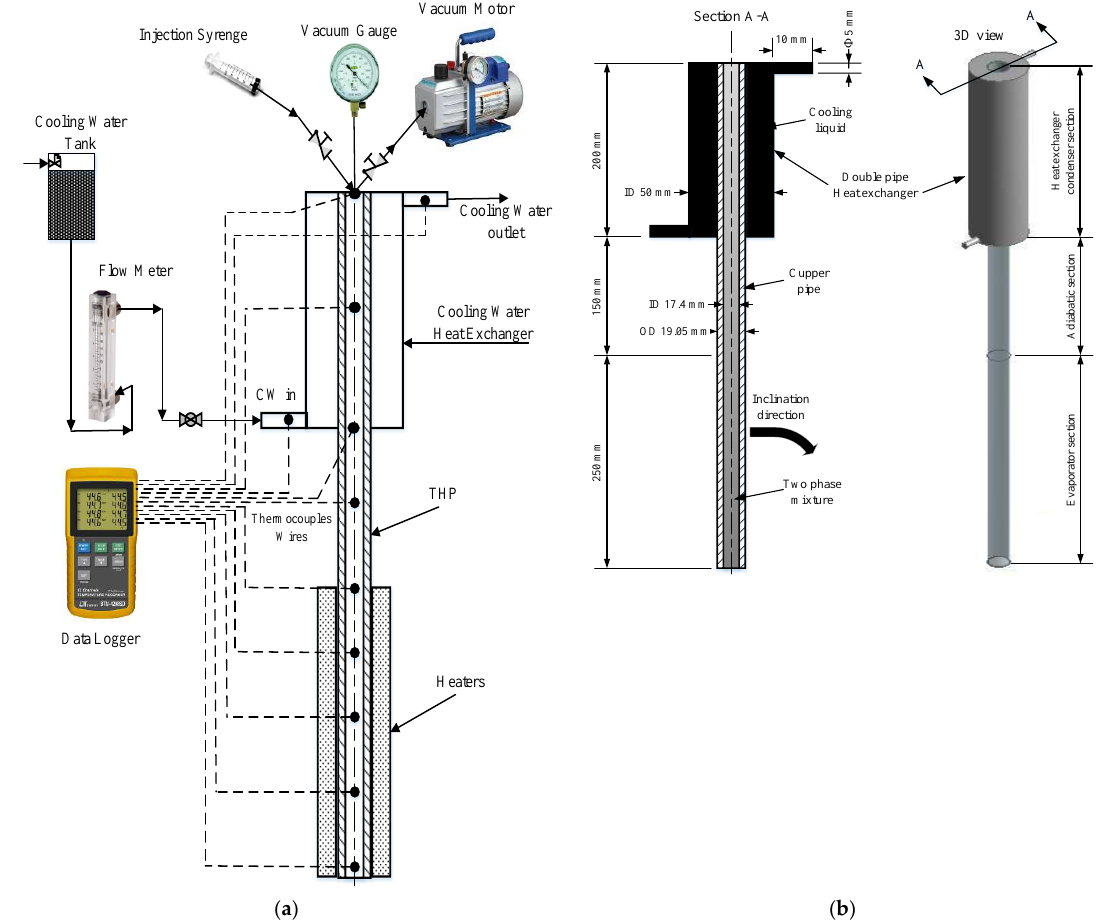
Figure 1. ( a ) Schematic diagram of the test rig (THP without TP). ( b ) THP model geometry and dimensions (THP without TP). Table 1. THP geometry and operating